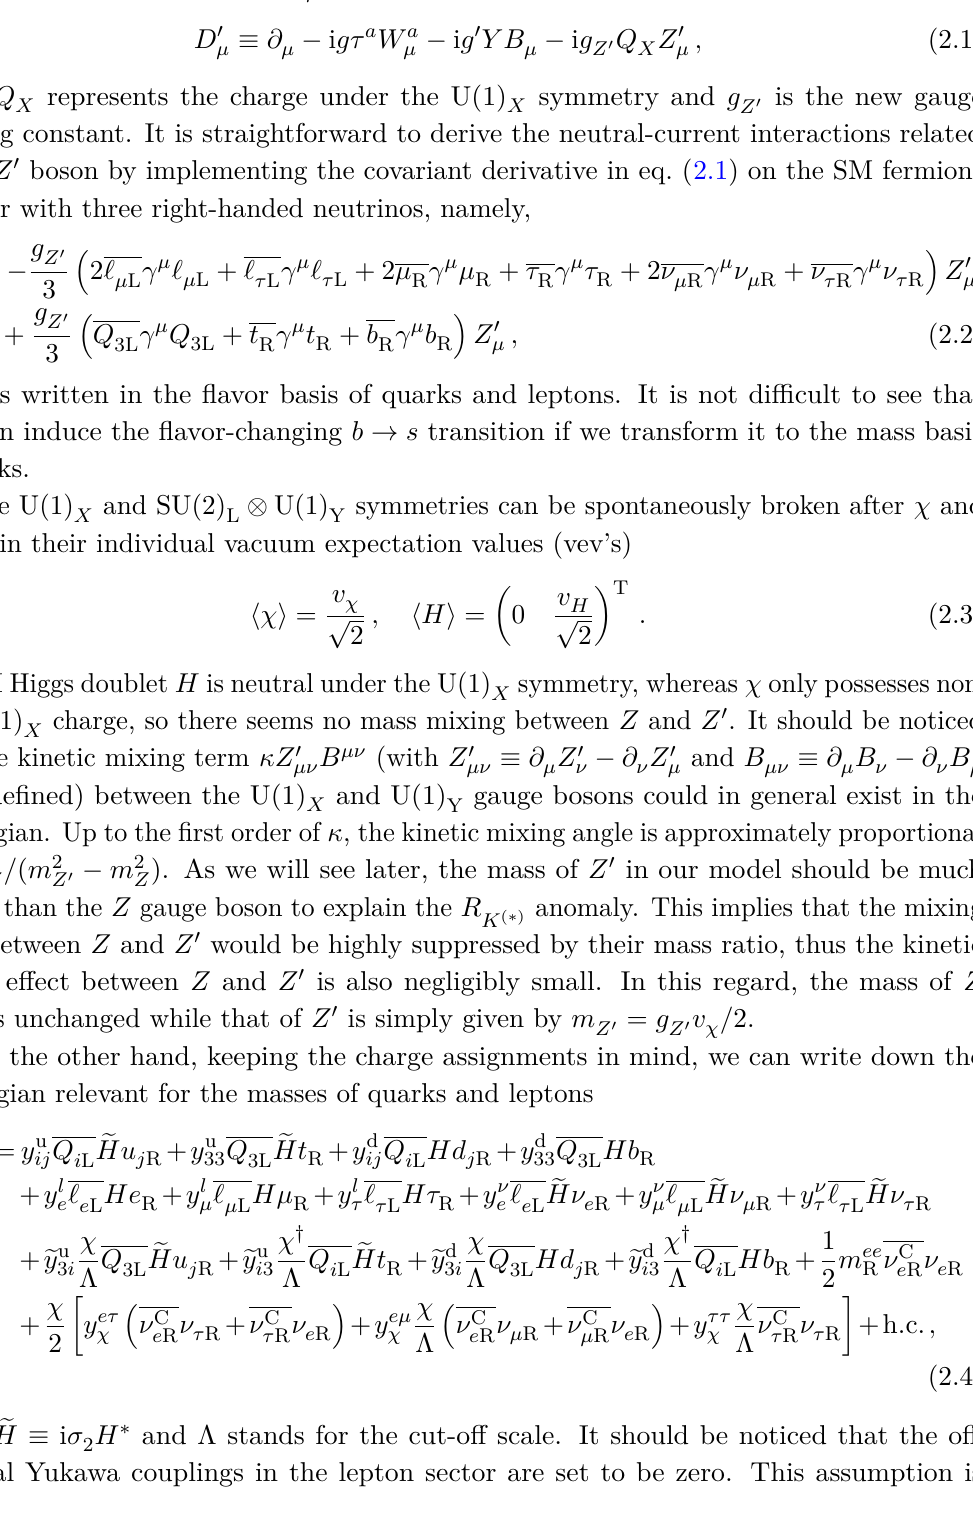
table 1. Due to the gauge field Z 0